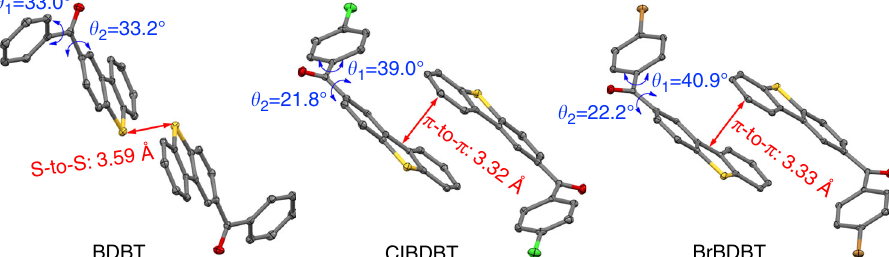
Fig. 5 Crystal structures of BDBT, ClBDBT and BrBDBT. (Carbon, oxygen, sulfur, chlorine, and bromine atoms are shown as gray , red , yellow , green , and orange ellipsoids at the 50% probability level, and hydrogen atoms are removed